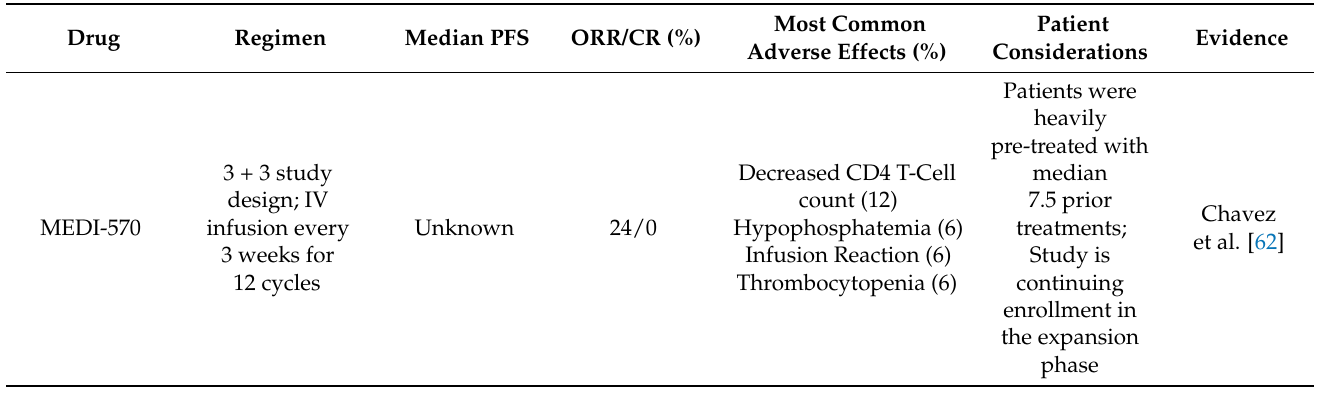
Table 3. Single Agent Investigational